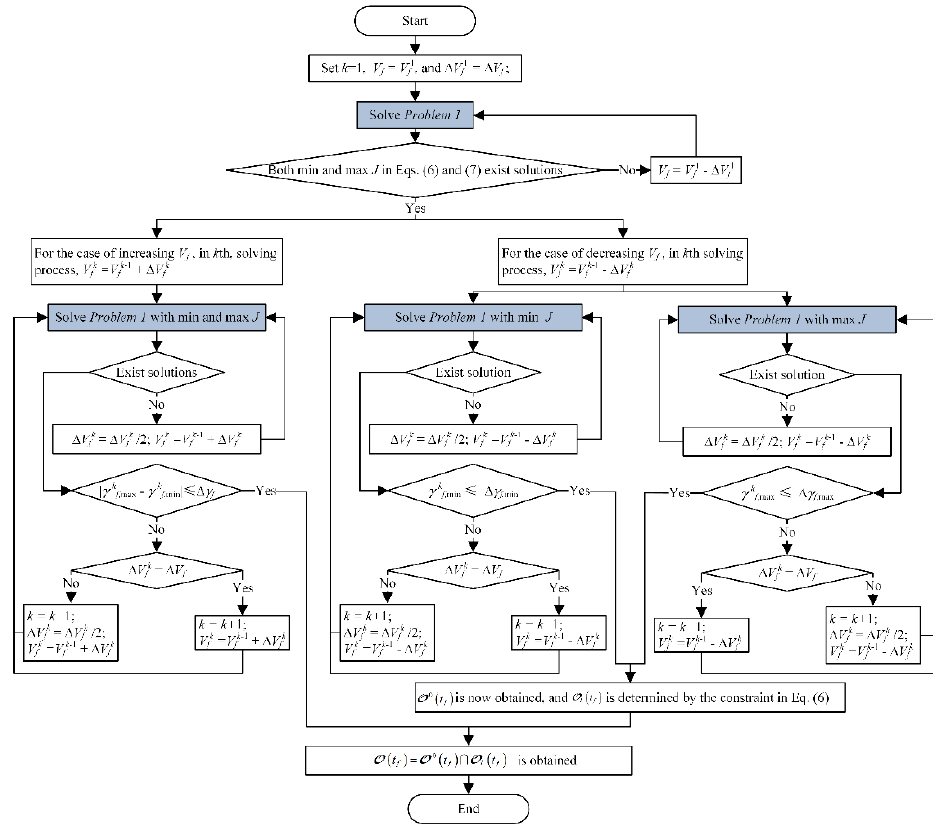
Figure 5. The algorithm flowchart for numerically solving the boundary of aerocapture attainability set.